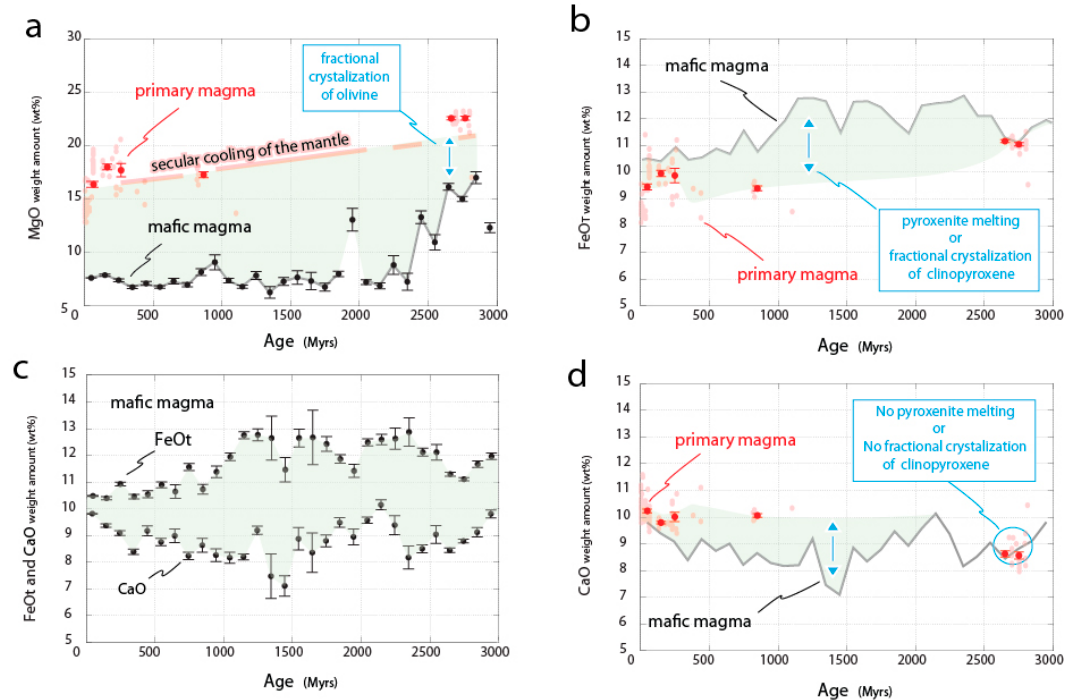
Figure 6. Chemical signature of mafic and primary magma throughout geological time. ( a , c ) Range of composition (FeO T , CaO and MgO wt%) for mafic magmas (43 < SiO 2 < 51 wt%) sampled around the world (>22,000 samples) and statistical assessment of the averaged-values evolution through time (black drawbars; uncertainty bars correspond to ± 1 σ standard deviation for age step of 100 Myrs). Averaged composition of primary magmas (103 samples, light red dots) (i) calculated with PRIMELT3 MEGA software [36], (ii) using reduced (Fe 2 O 3 /TiO 2 = 0.5) conditions in the source and (iii) filtered for MgO > 10% [28], was reported on the graphs (red points). A decrease in FeO T , CaO and MgO wt% of the primary magmas is observed since the end of the Archaean (~2.5 Gyrs). ( b , d ) The divergence in MgO (wt%) between mafic and primary magmas can be explained by a fractionation of olivine (red arrows) ; the divergence in FeO T and CaO (wt%) requires either a subtraction (black arrows) of clinopyroxene from the primary melt or a melting of residual material (pyroxenite) in the lithosphere.